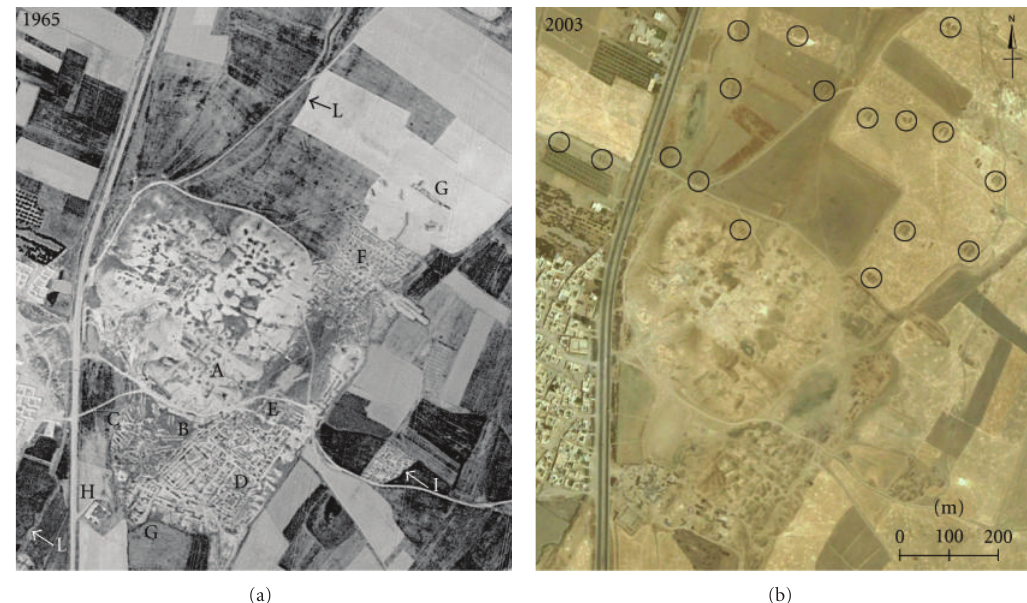
Figure 11: The Citadel of Dur-Sharrukin in a Gambit KH-7 photo of 1965 and in a pan-sharpened (bands 3-2-1) QuickBird-2 image of 2003: (A) Palace of Sargon; (B) Nabu Temple; (C–F) Residences (M, J, K, and L; G) remains of the walls defending the Citadel; (H) Sibitti Temple; (I) Residence Z; (L) city walls; small circles highlight some military